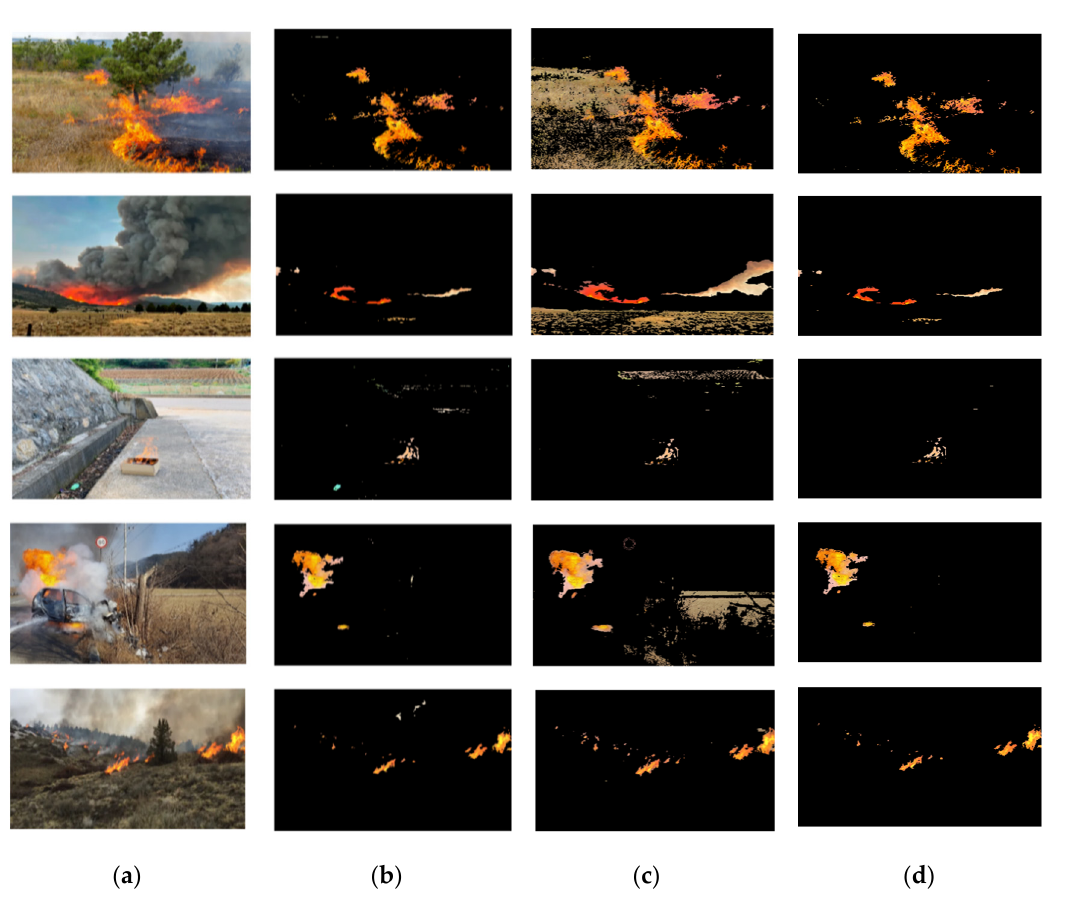
Figure 3. Color conversion of flame images. ( a ) Original images; ( b ) HSV color conversion images within the range; ( c ) YCbCr color conversion images to which the rule is applied; ( d ) Images to which both YCbCr and HSV color conversion are applied.